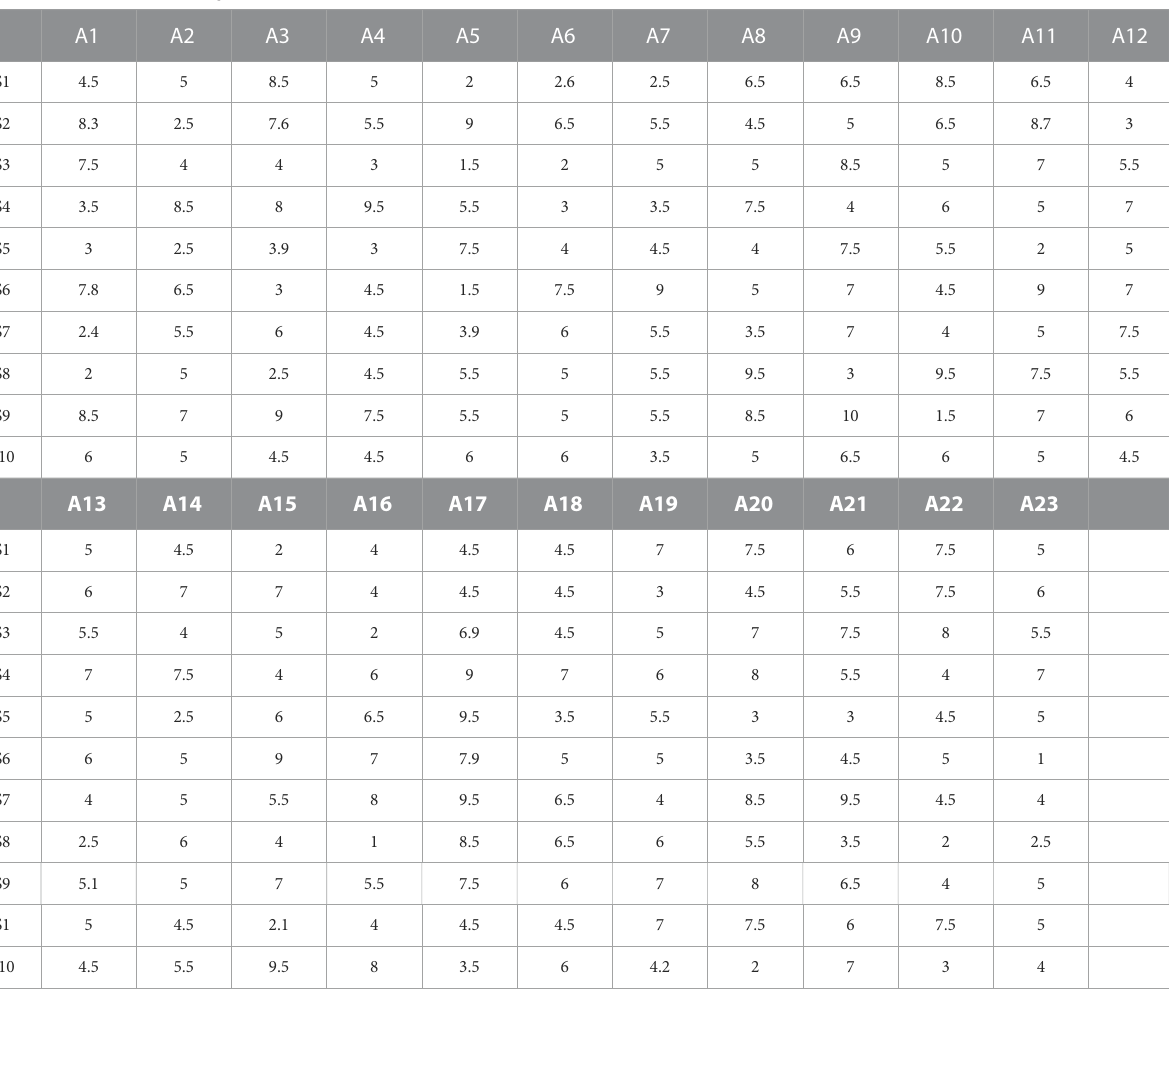
TABLE 5 Decision matrix of the problem (Source: Author).